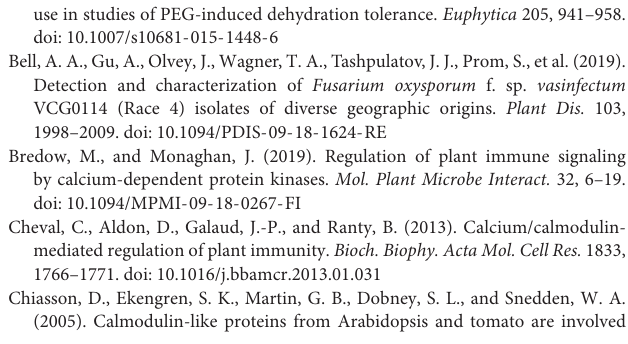
Supplementary Figure 1 | Genetic linkage map and genome collinearity